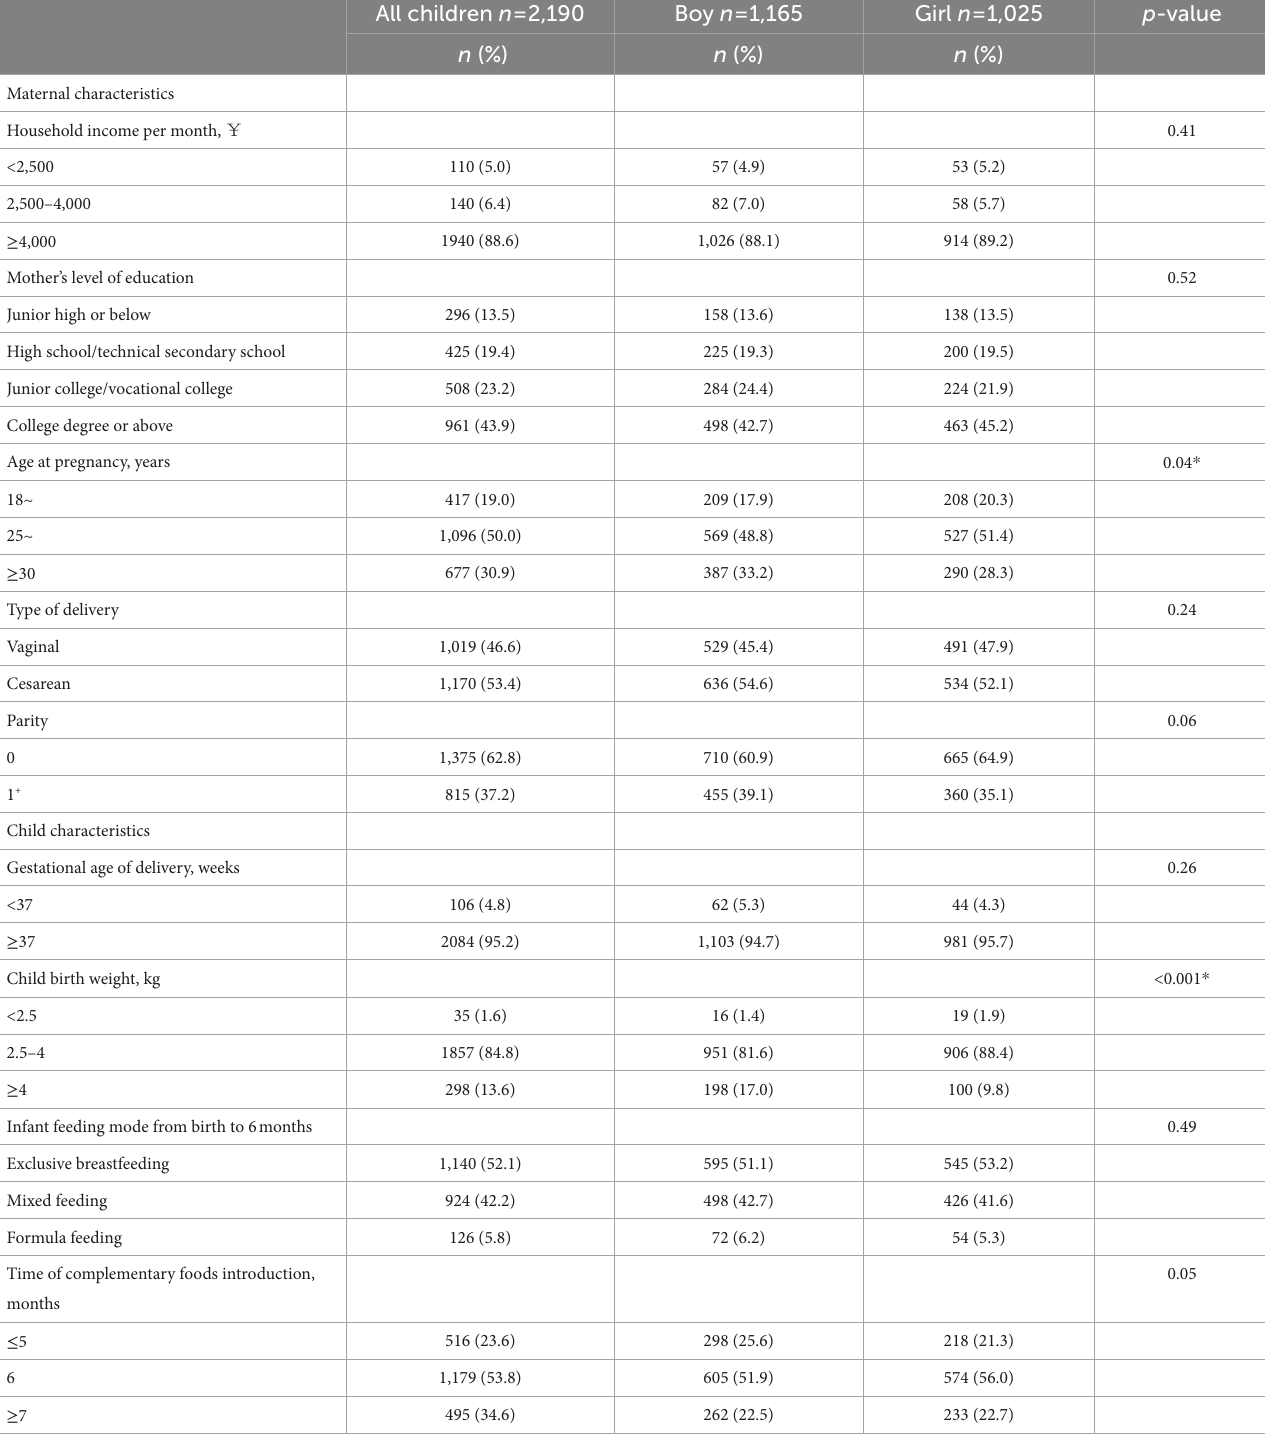
TABLE 1 Population characteristics of participants ( N =